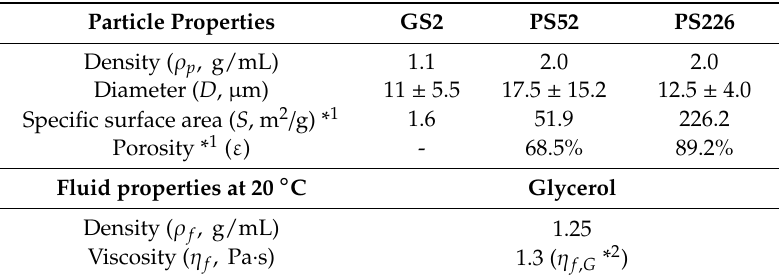
Table 1. Particle and solvent